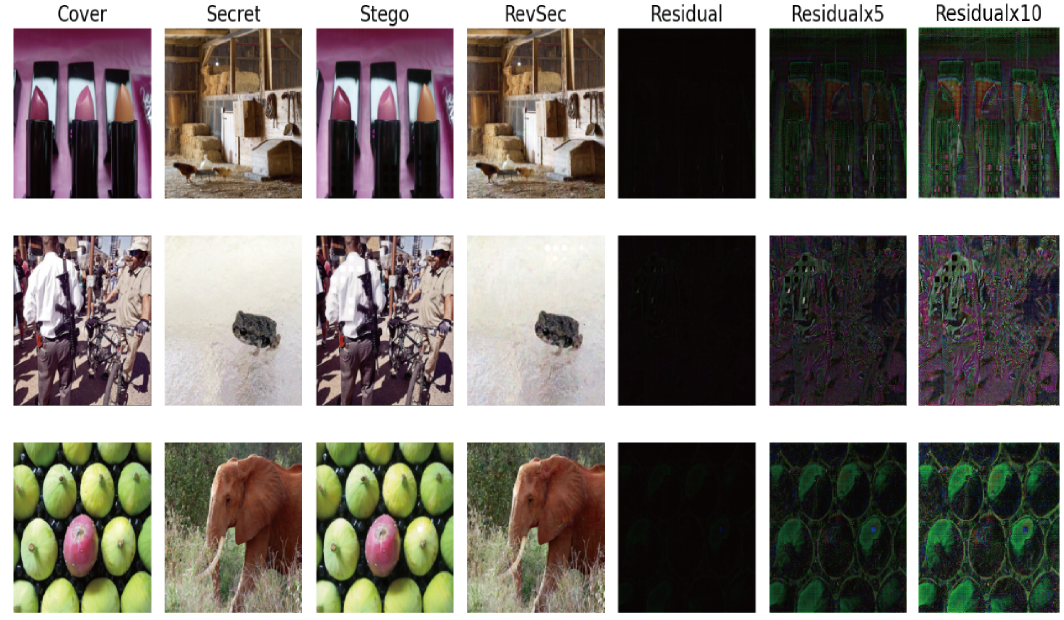
Figure 6. Randomly select three sets of images for subjective visual